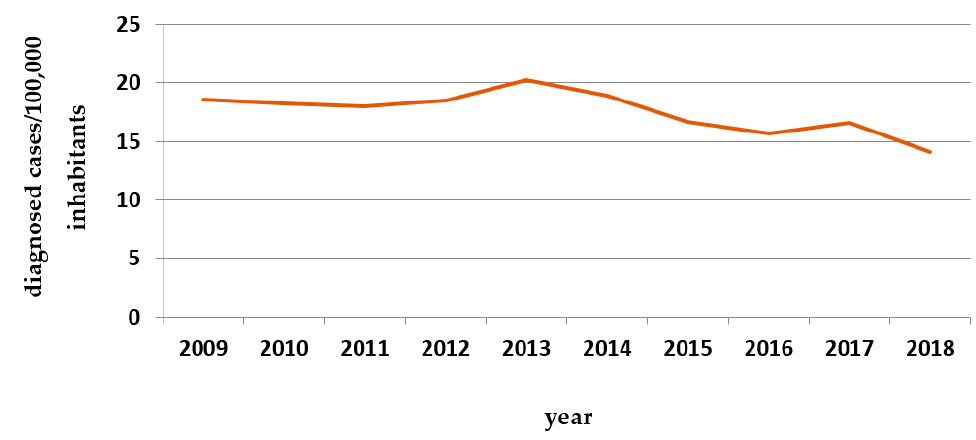
Figure 2. Number of cases diagnosed in Portugal with “diabetic foot” per 100,000 inhabitants (hospital admissions) since 2009 to 2018. Source: INFARMED [13].